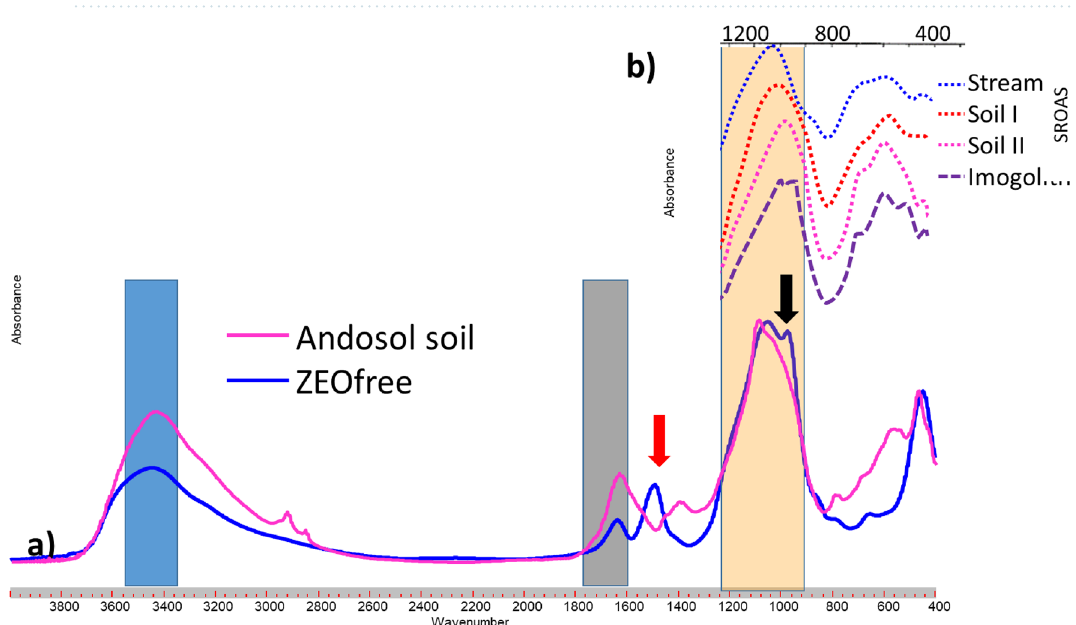
Figure 3. ( a ) FTIR spectra (400–4000 cm −1 ) of ZEOfree and an Andosol soil from Ecuador (Soil I + II) as well as ( b ) a 400–1400 cm −1 section of the FTIR spectra of SROAS, and imogolith (Imogol.; adapted from Parfitt 32